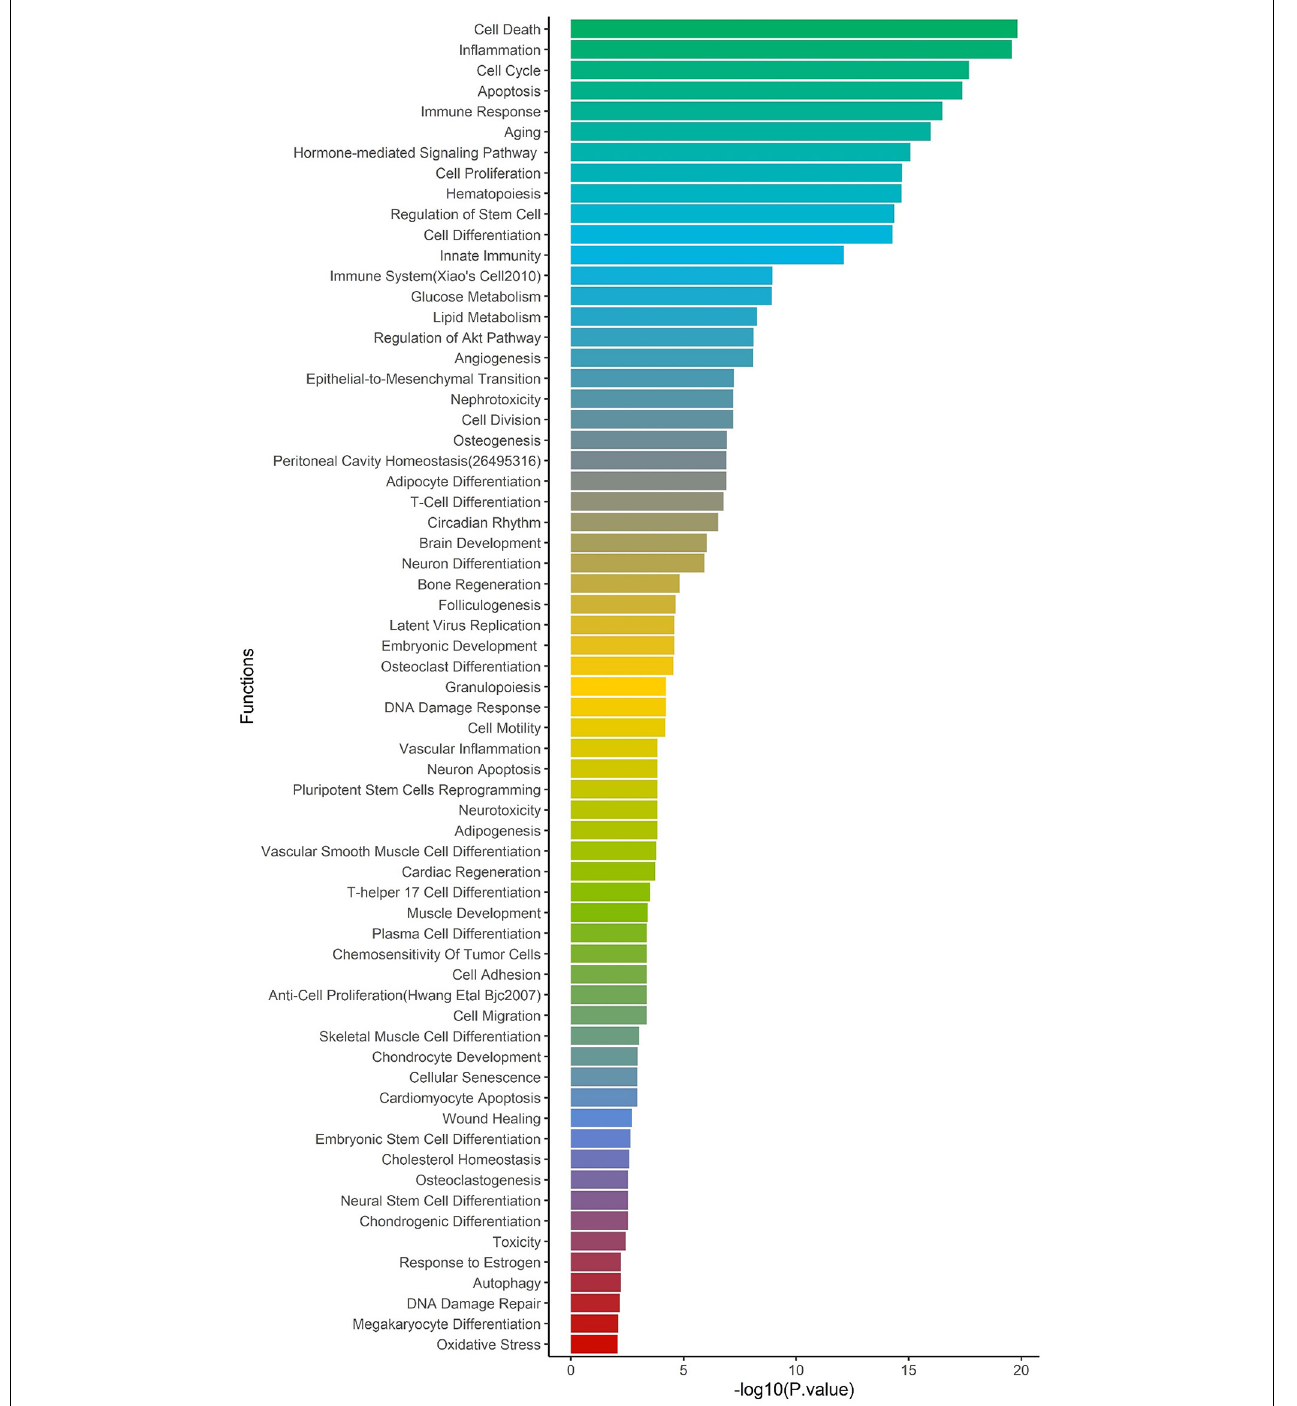
FIGURE 4 | Enrichment of biological functions based on miRNA:SNP annotation. Using miRNAs annotation, over-represented biological processes are shown on y -axis and –log10 p -value on x -axis.